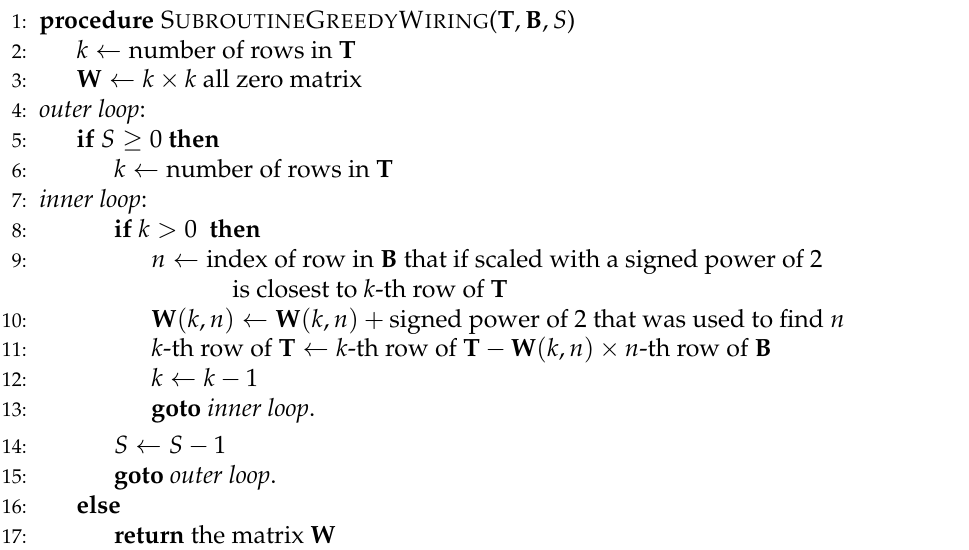
Algorithm 2 Subroutine used in Algorithm